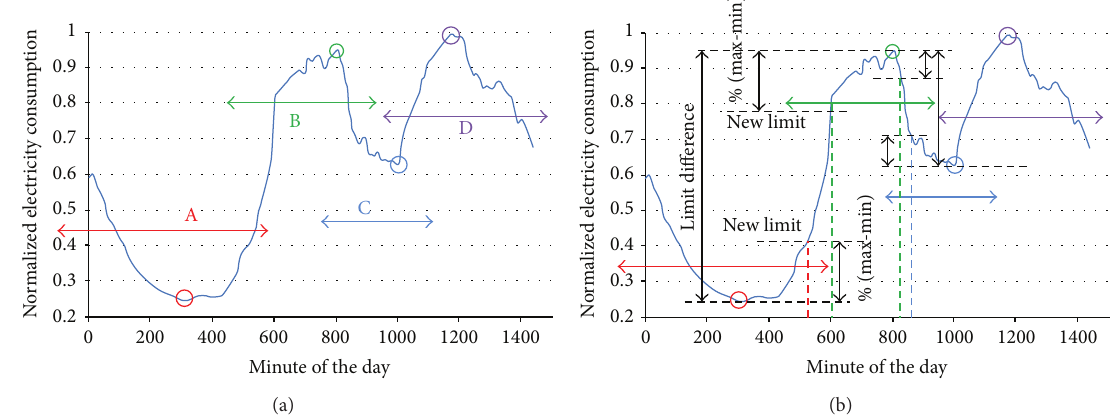
Figure 4: Linearization process. (a) Definition of the first four slots. (b) Definition of limit difference and new limits.